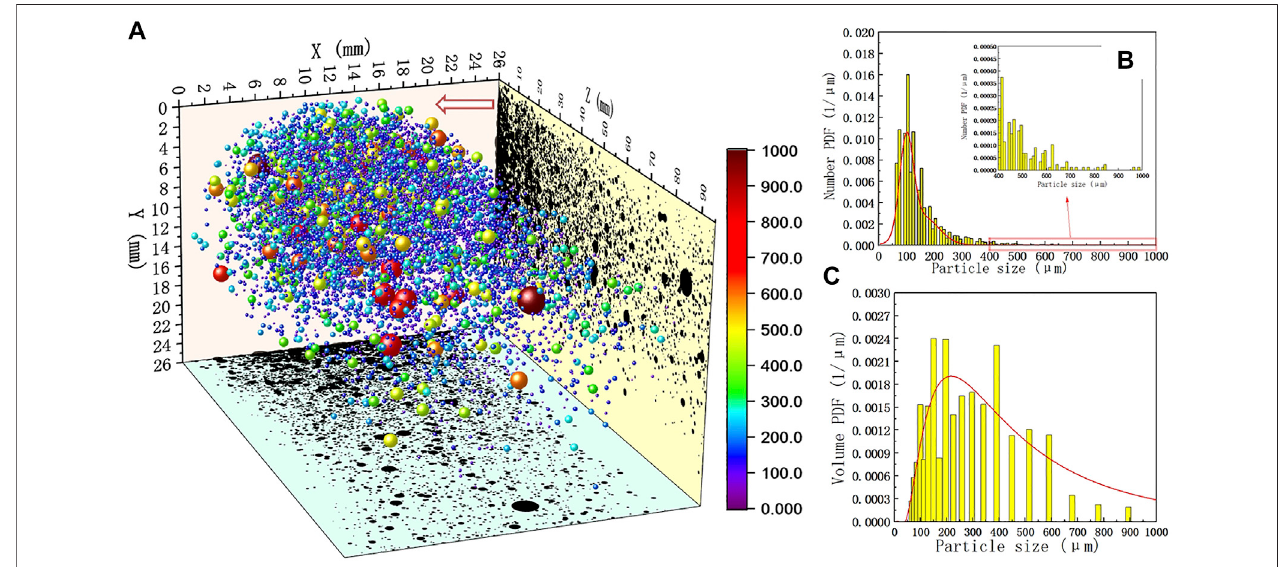
FIGURE 4 | (A) Three-dimensional spatial distribution of the plume particle fi eld (B) N -PDF and (C) V -PDF histograms of all the combustion